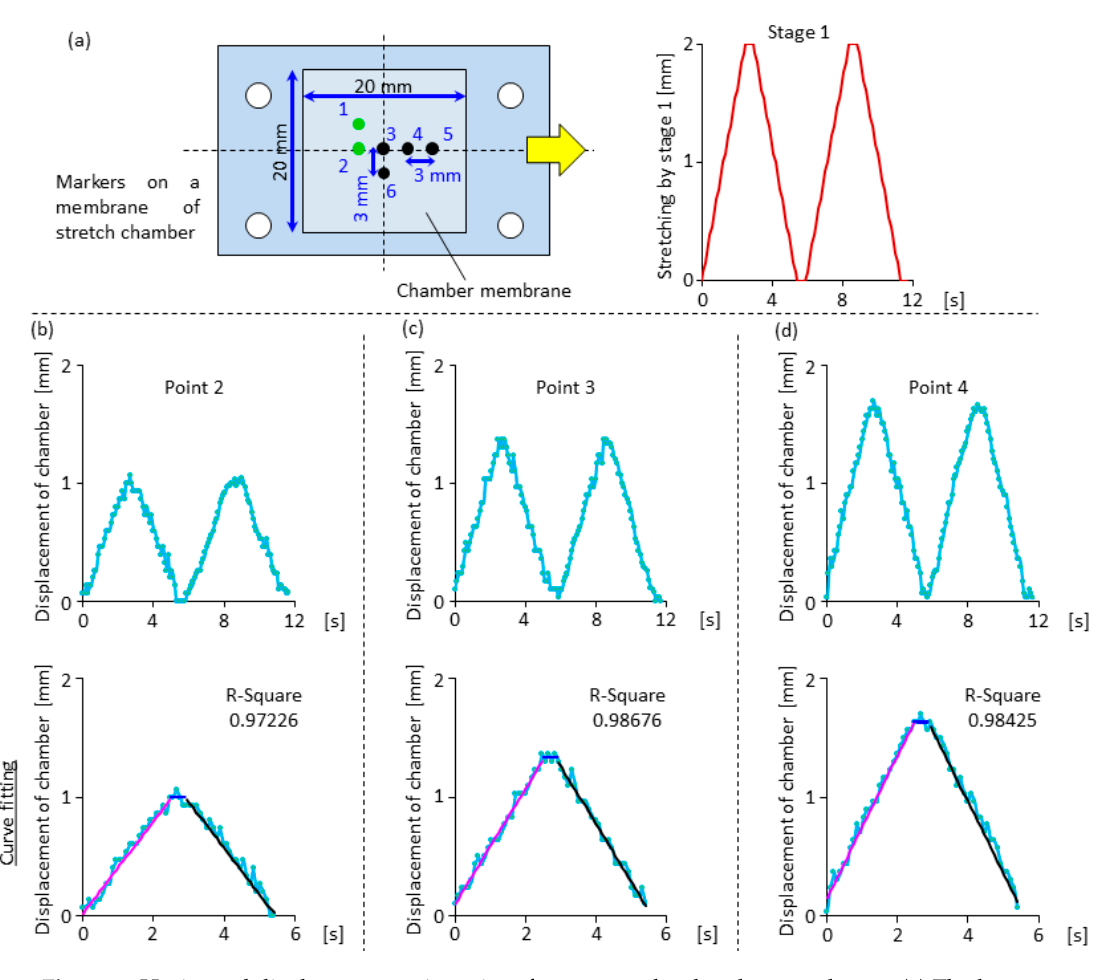
Figure 4. Horizontal displacement trajectories of targets on the chamber membrane. ( a ) The layout of targets on the chamber membrane and the waveform for the control of stage 1/chamber stretching. ( b ), ( c ), or ( d ) Upper: a typical waveform of point 2, 3, or 4 when the chamber was stretched. Lower: the fit results of the stretching/holding/relaxation phases of the corresponding upper waveform. From ( b ), original data is drawn in light blue. The lines with color in purple, blue, and black are the lines fitting for the lengthening, holding, and relaxation phases, respectively.